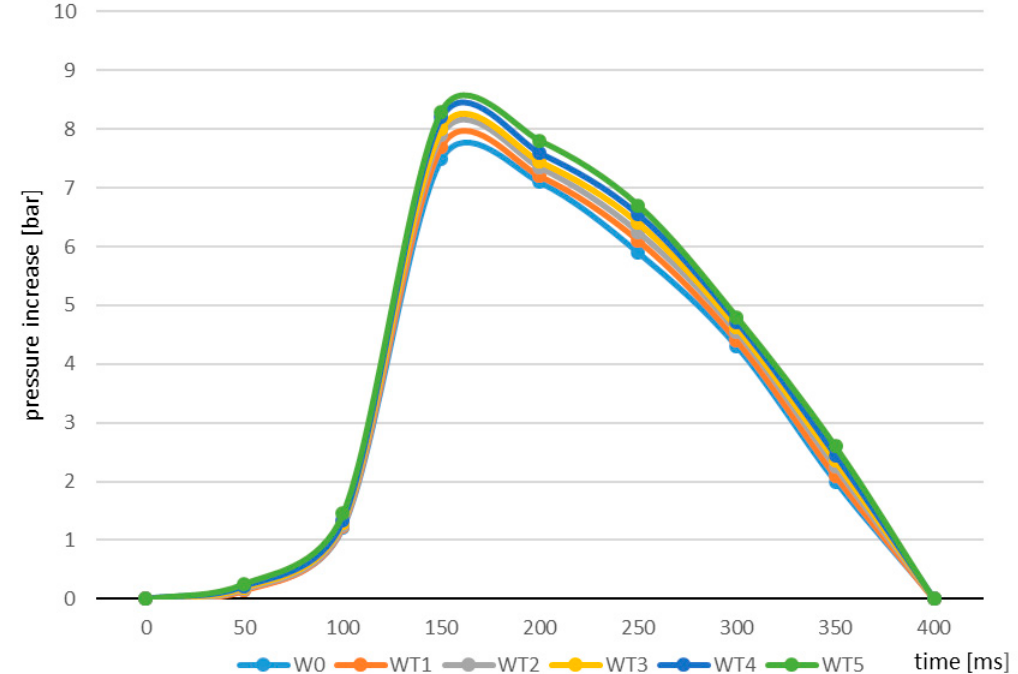
Figure 2. Explosion pressure curve identified for samples of raw and torrefied willow material.